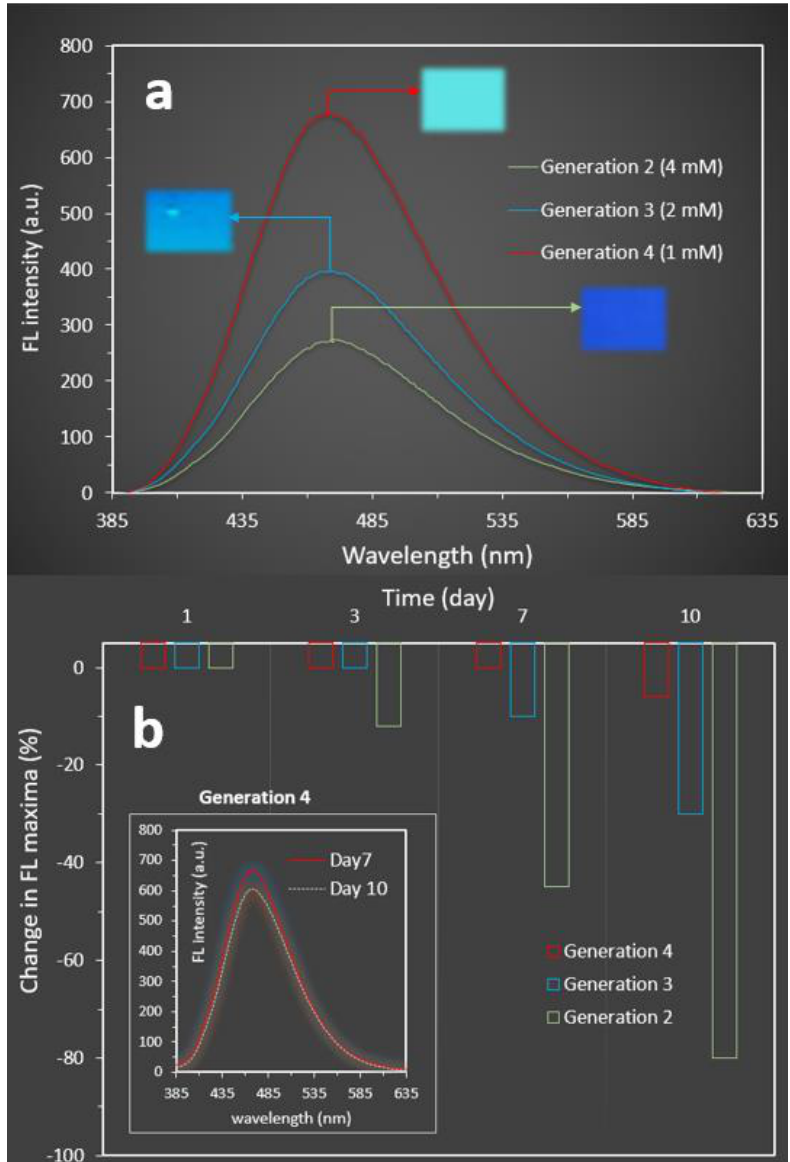
Figure 3. ( a ) Changes in the fluorescence intensities versus the concentrations of HBs to obtain an equal total number of OH groups (WF = 90%); insets: camera images of nanoprobe solutions captured under a UV light with the excitation wavelength of 365 nm). ( b ) The stabilities of the nanoprobes prepared using different generations of HB were measured over 10 days (at WF = 90%, concentration = 1 mM, and the excitation wavelength = 310 nm).